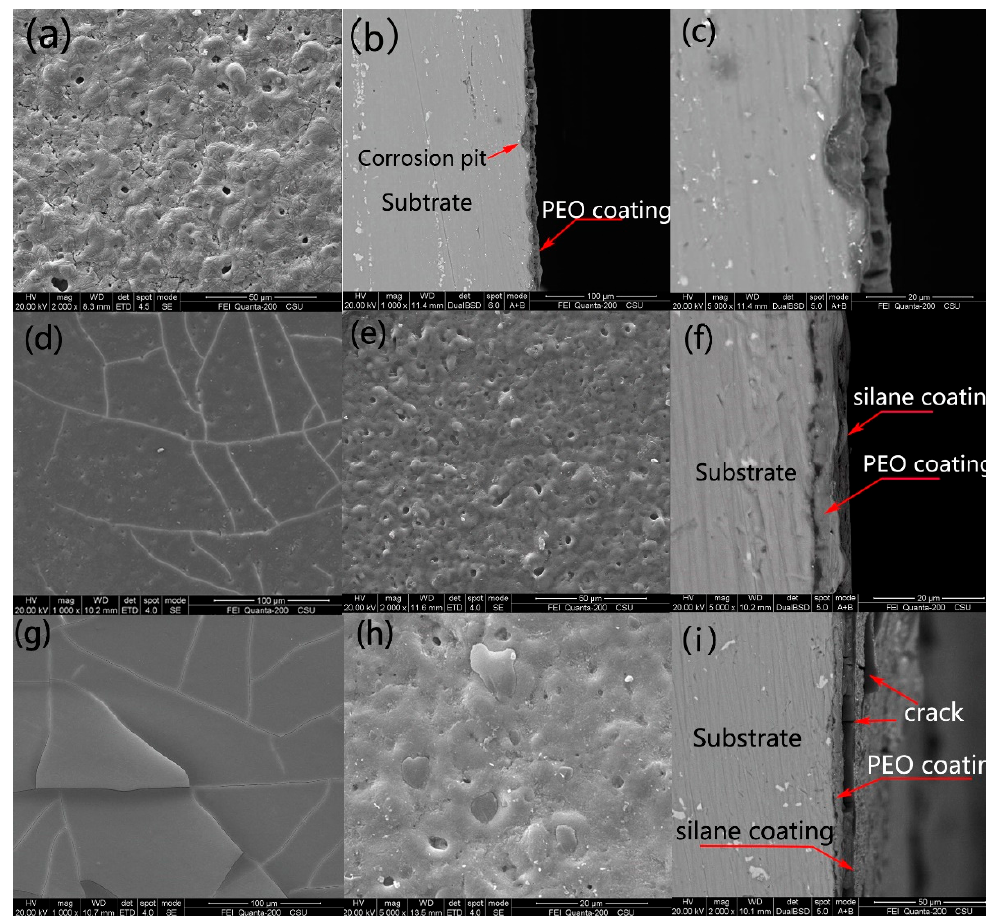
Figure 10. Surface and cross section morphology of samples after immersion in 3.5 wt.% NaCl solution for 576 h: ( a – c ) PEO coating; ( d – f ) PEO-S1 coating; ( g – i ) PEO-S2 coating; ( e , h ) removed the silane coating.